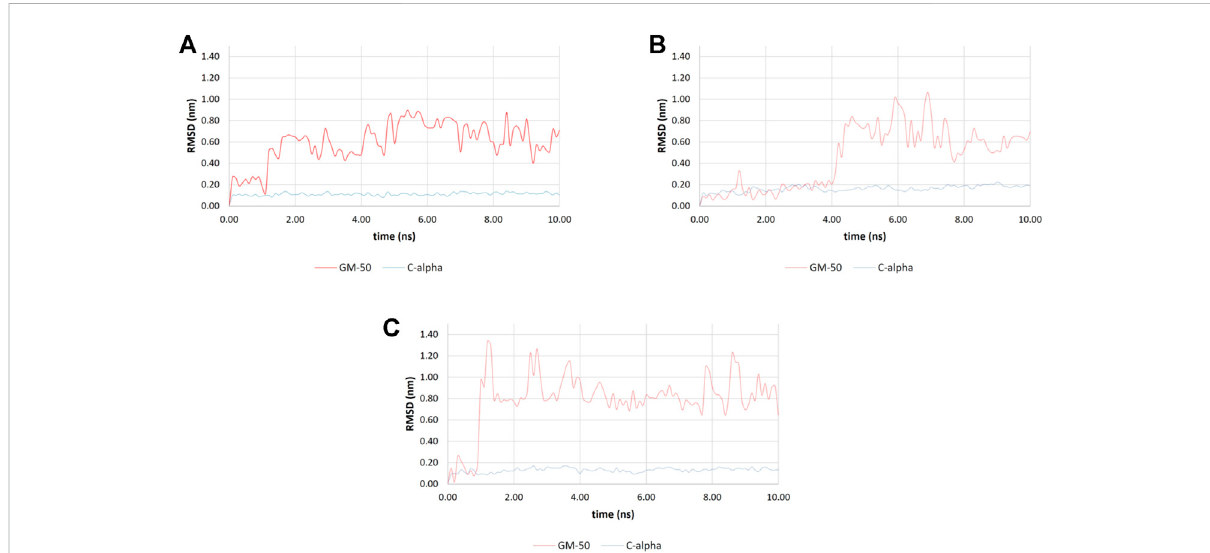
FIGURE 7 Molecular docking simulations. Root mean square deviation (RMSD) values were obtained during the fi rst 10 ns of molecular dynamics simulations. (A) RMSD values fortheLasRC-alpha atoms (blueline)and GM-50(displacementofligand heavyatomswith respect toproteinC-alpha atoms; red line). (B) RMSD values for the RhlI C-alpha atoms (blue line) and GM-50 (displacement of ligand heavy atoms with respect to protein C-alphaatoms;redline). (C) RMSDvaluesfortheLasIC-alphaatoms(blueline)andGM-50(displacementofligandheavyatomswithrespectto protein C-alpha atoms; red line). In all the cases, while the proteins resulted stable during the simulations, the ligand was readily displaced from the binding site (RMSD > 0.6 nm within 10